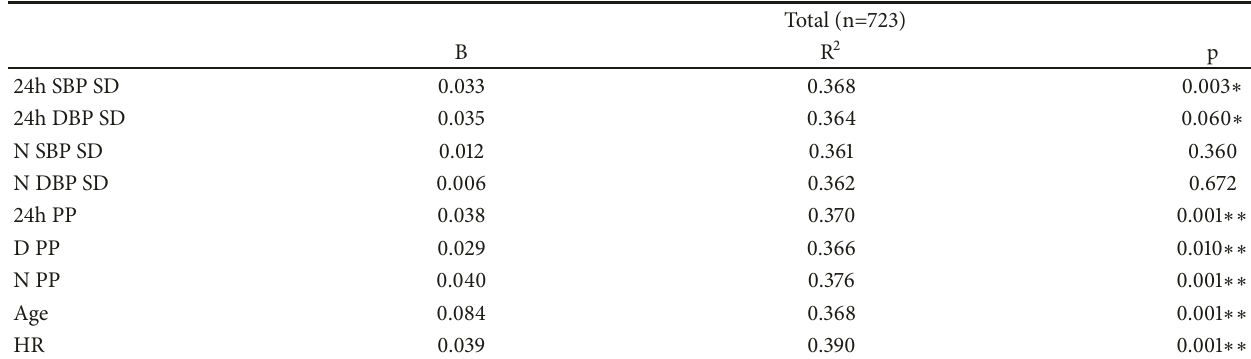
Table 4: Association of CF-PWV with BPVs and PP in overall population, by multivariable-adjusted linear regression analysis.